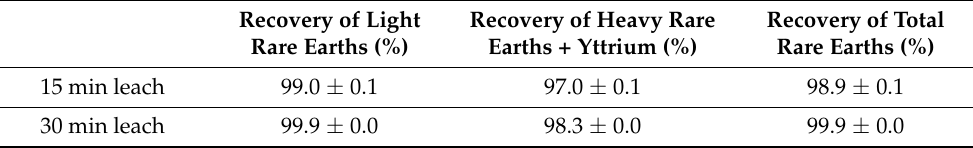
Table 7. Overall light and heavy rare earth dissolution (%): Mozambique monazite.